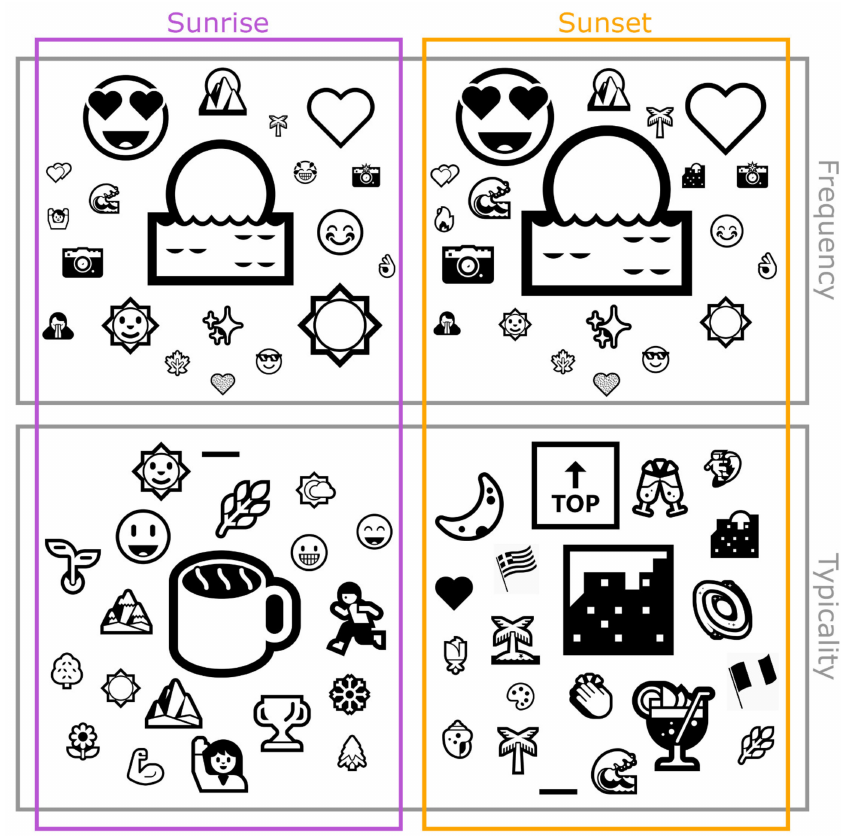
Figure 2. Emoji clouds of the frequency- and typicality-based top 20 emojis of the global sunset- and sunrise-related